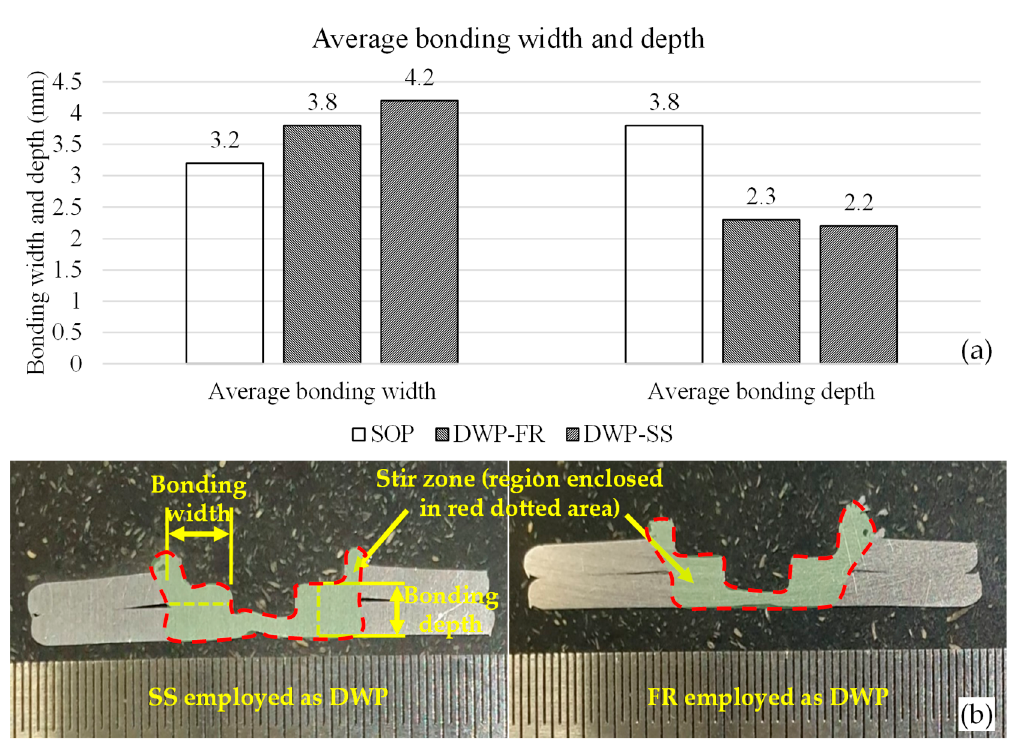
Figure 15. ( a ) Comparison of the stress–strain curves under different welding conditions. ( b ) Typical examples of the welds’ fractured areas.